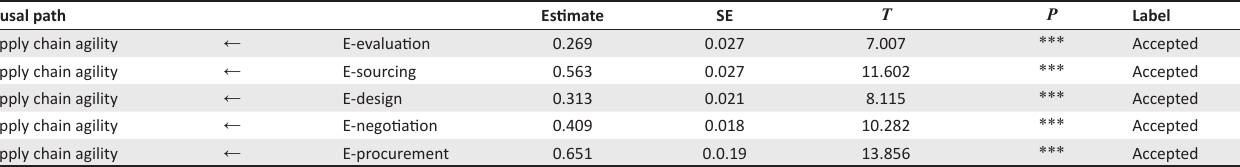
TABLE 4: Hypotheses testing summary. Causal path Estimate